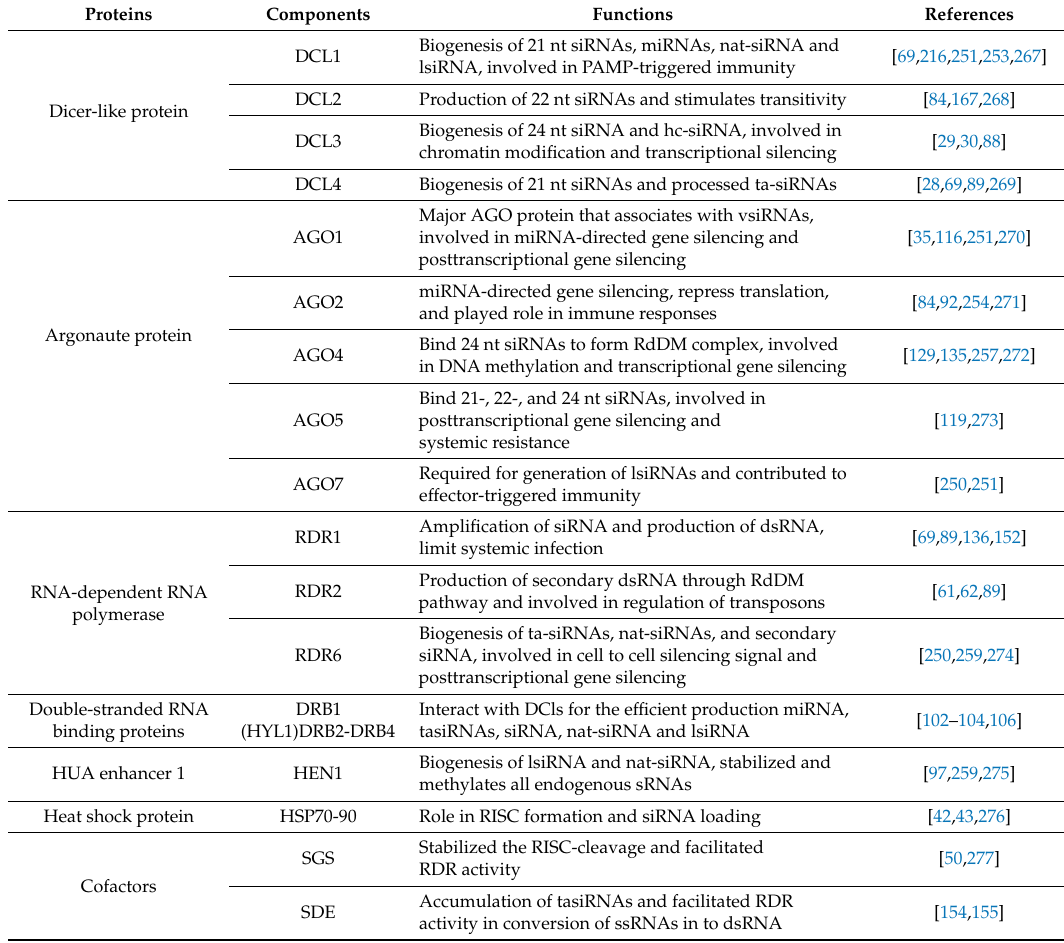
Table 2. Diversity of RNA interference (RNAi) pathway essential components involved in plant immunity.